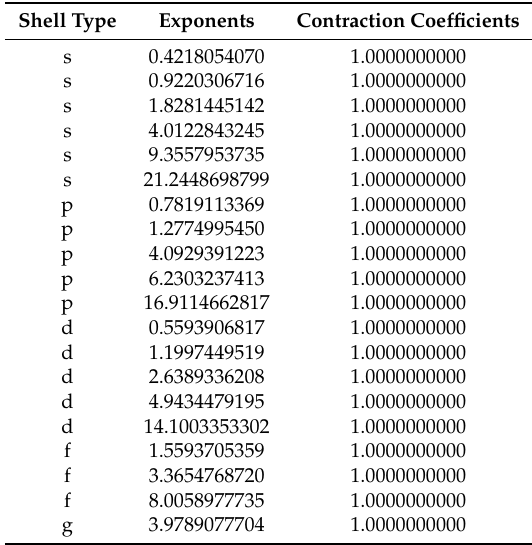
Table A25. Parameters of the cc-TZVP auxiliary basis set of